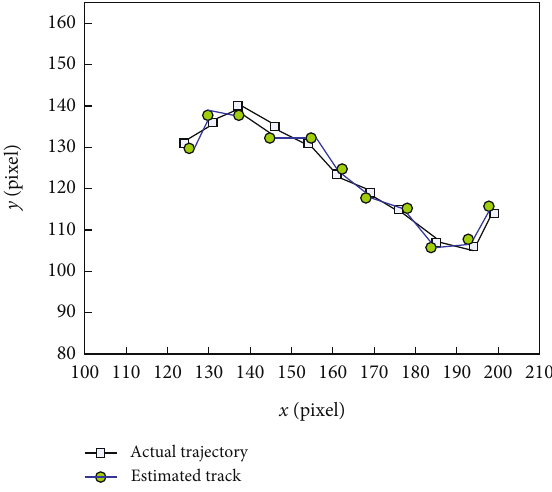
Figure 7: Target position and tracking result statistic